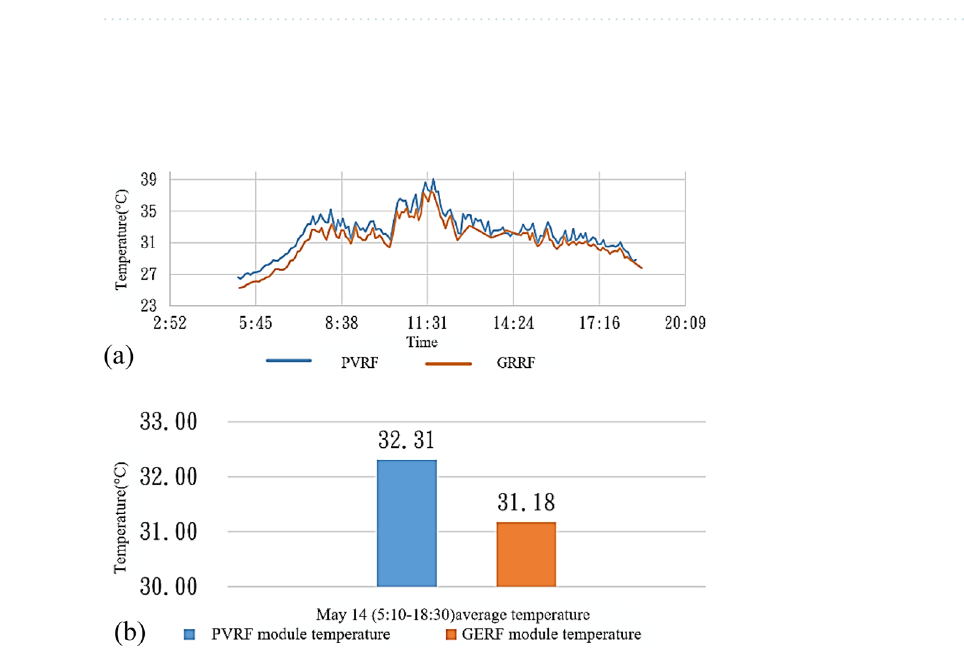
Figure 10. ( a ) Smallest temperature changes, ( b ) indoor roof humidity, and ( c ) indoor–outdoor temperatures on April 6.